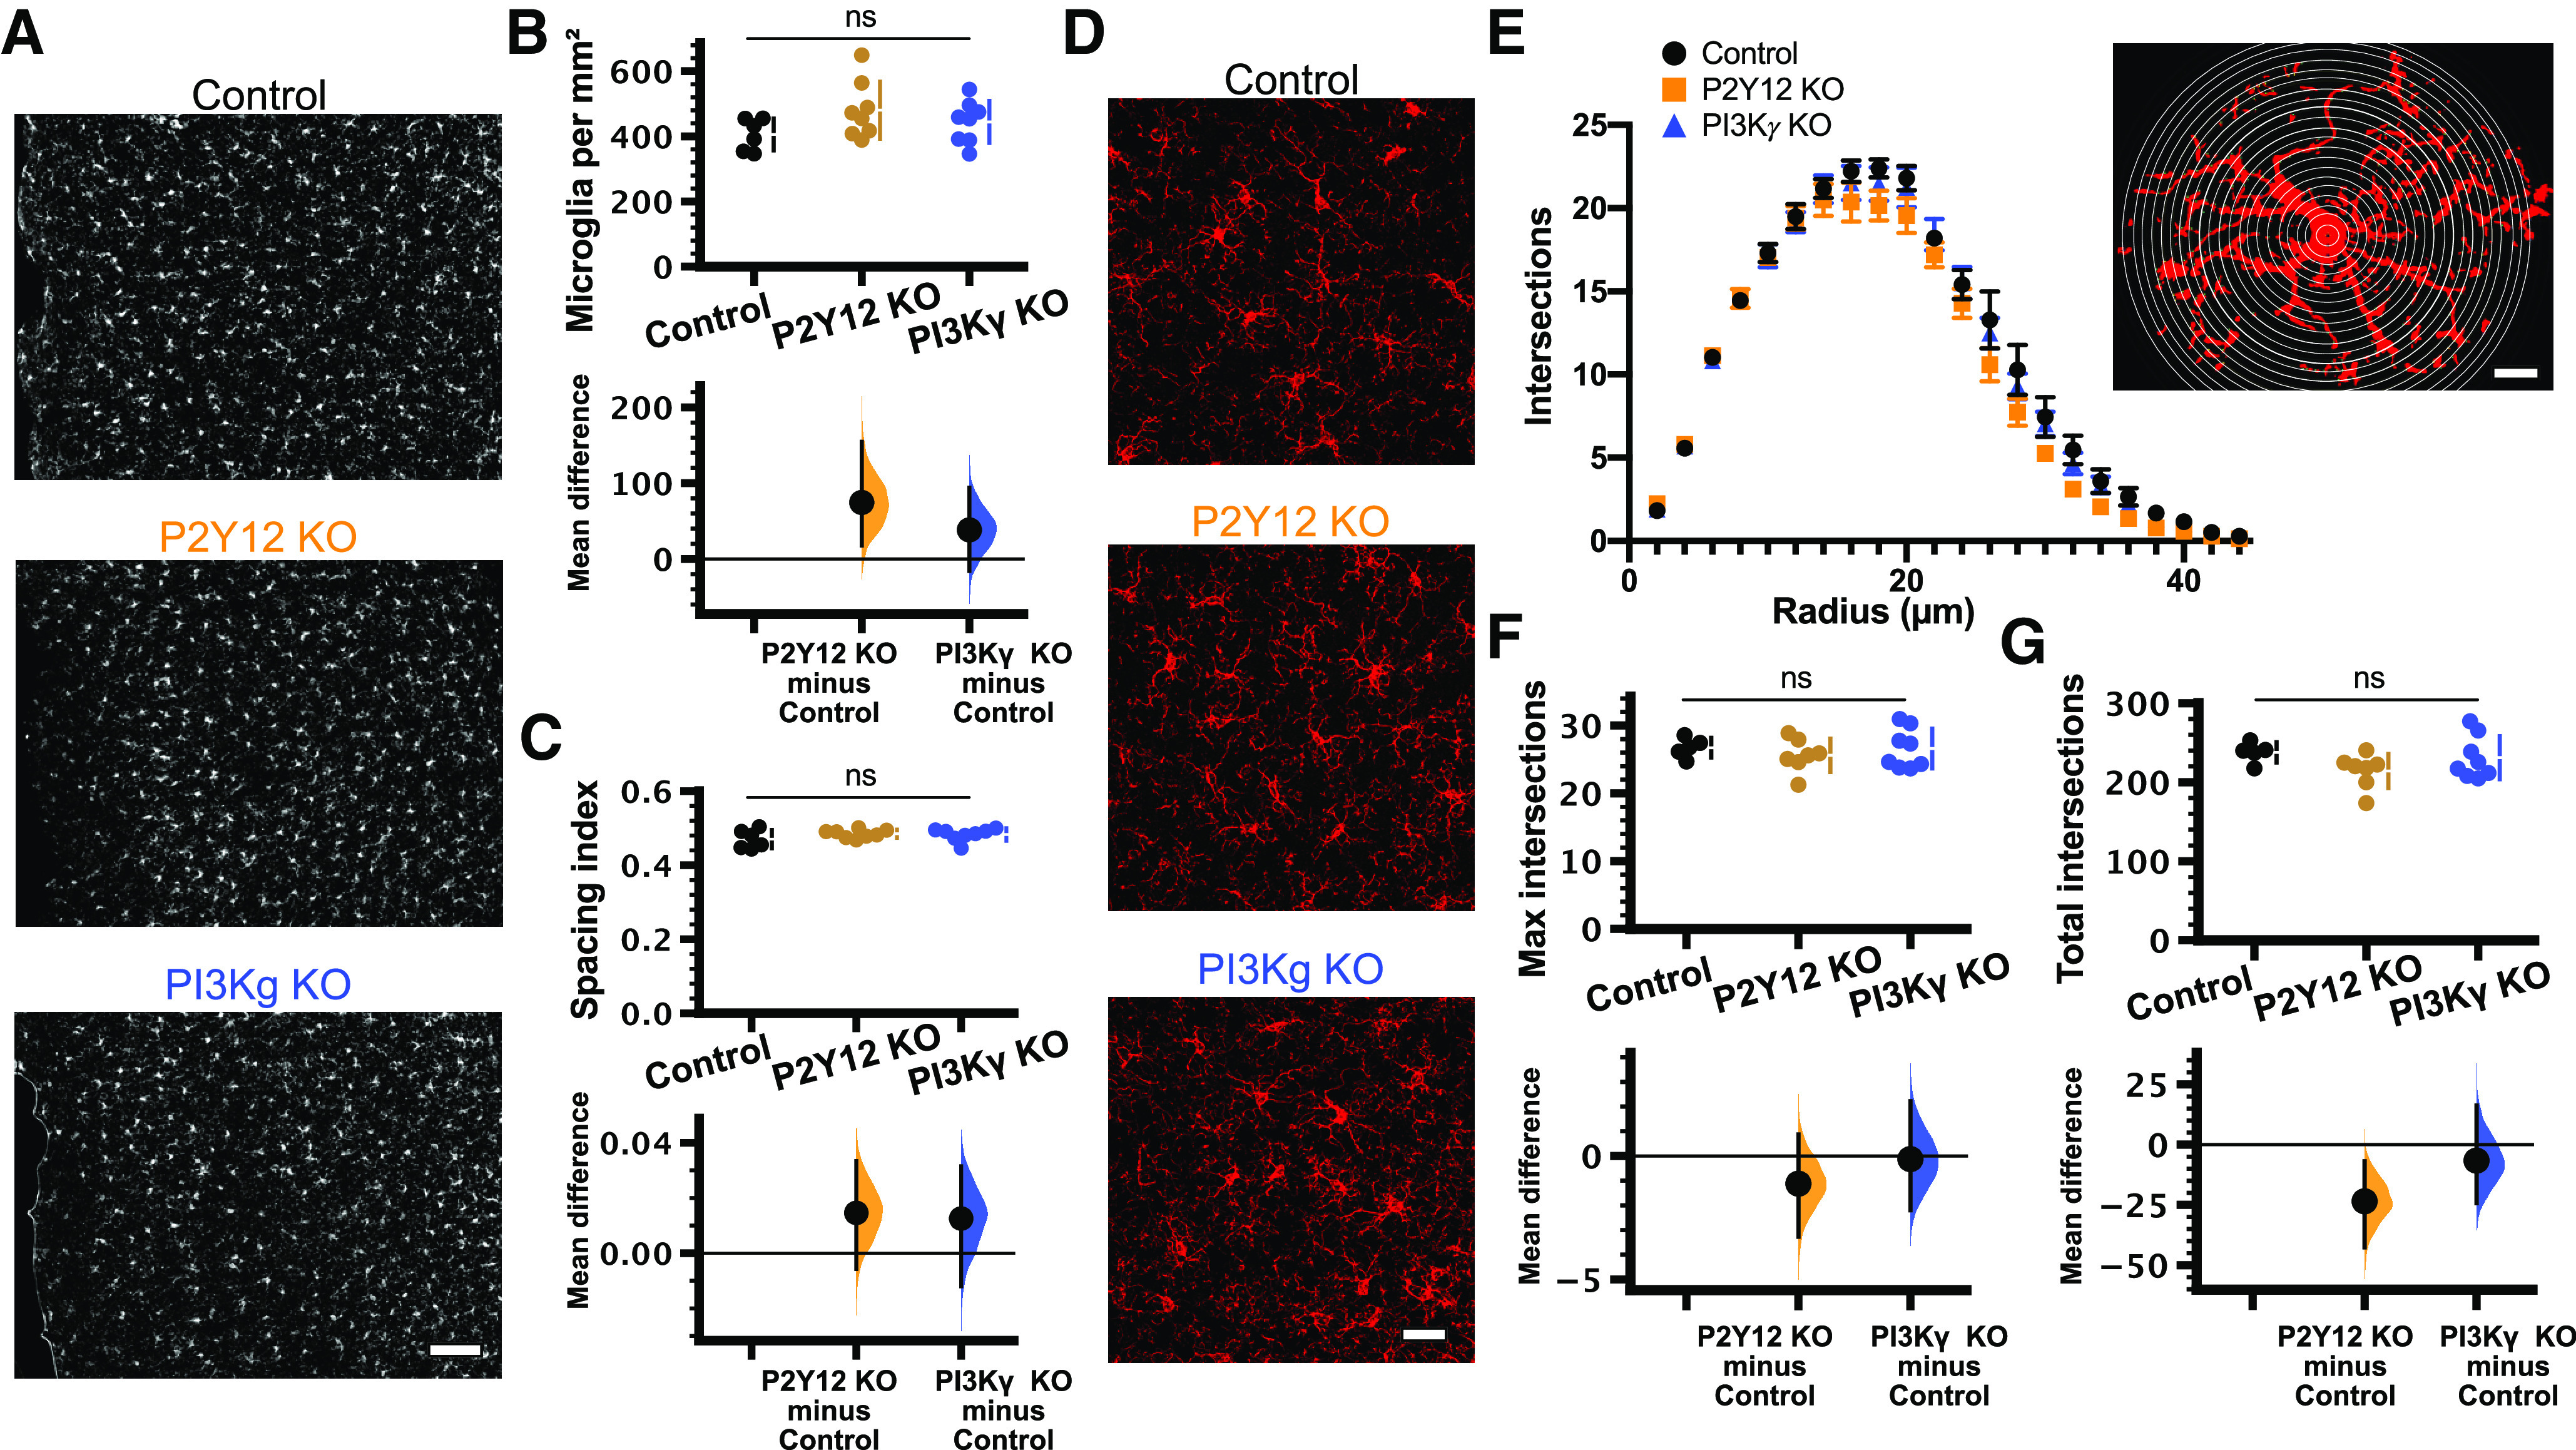
Microglial density, distribution, and morphology was unaffected in PI3Kγ KO mice. A, Representative 10× epifluorescent images of Iba1-stained microglia in V1 from C57BL/6 control (top), P2Y12 KO (middle), and PI3Kγ KO (bottom) mice (scale bar: 100 μm). The mean difference for comparisons against the shared control are shown in the Cumming estimation plots. The raw data are plotted on the upper axes. On the lower axes, mean differences are plotted as bootstrap sampling distributions. Each mean difference is depicted as a dot. Each 95%CI is indicated by the ends of the vertical error bars. Analysis of the number and location of microglial cell bodies [n (animals) = 5 control; 7 P2Y12 KO; 8 PI3Kγ KO] revealed no differences in either cell density [B; one-way ANOVA p = 0.18; unpaired mean differences vs control: P2Y12 KO 74.6 (95%CI 17.7, 155); PI3Kγ KO 38.4 (95%CI −15.7, 94.1)] or the spacing index [C; one-way ANOVA p = 0.30; unpaired mean differences vs control: P2Y12 KO 0.0146 (95%CI −0.00574, 0.0334); PI3Kγ KO 0.0125 (95%CI −0.012, 0.0315)]. D, Representative 40× confocal images of Iba1-stained microglia from the C57BL/6 control (top), P2Y12 KO (middle), and PI3Kγ KO (bottom) mice (scale bar: 30 μm). E–G, Analysis of the branching complexity by Sholl analysis. E, Plot of the number of intersections as a function of radius showed no apparent differences between genotypes [14–38 microglia per animal; n (animals) = 5 control; 7 P2Y12 KO; 8 PI3Kγ KO]. Inset, Schematic showing a representative microglial cell and the concentric rings (radius increasing in increments of 2 μm) used to calculate the number of processes as a function of distance from the soma (scale bar: 10 μm). Comparisons of the maximum number of intersections [F; one-way ANOVA p = 0.67; unpaired mean differences vs control: P2Y12 KO −1.12 (95%CI −3.27, 0.866); PI3Kγ KO −0.128 (95%CI −2.2, 2.22)] and the total intersections [G; one-way ANOVA p = 0.19; unpaired mean differences vs control: P2Y12 KO −23.5 (95%CI −42.6, −6.88); PI3Kγ KO −6.63 (95%CI −24.3, 16.2)] showed no differences between genotypes; ns, non-significant. Data are presented as mean ± SEM.